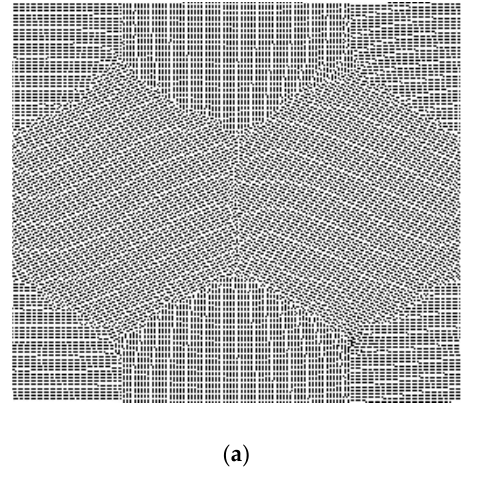
Figure 25. Moiré patterns from the atomic structures of nanocrystals with EGBDs for initial states 0.05_1 ( a ) and 0.15_1 ( b ) [121]. Table 3. Energies of grain boundaries in equilibrium and nonequilibrium nanocrystals at zero and room temperatures [121].